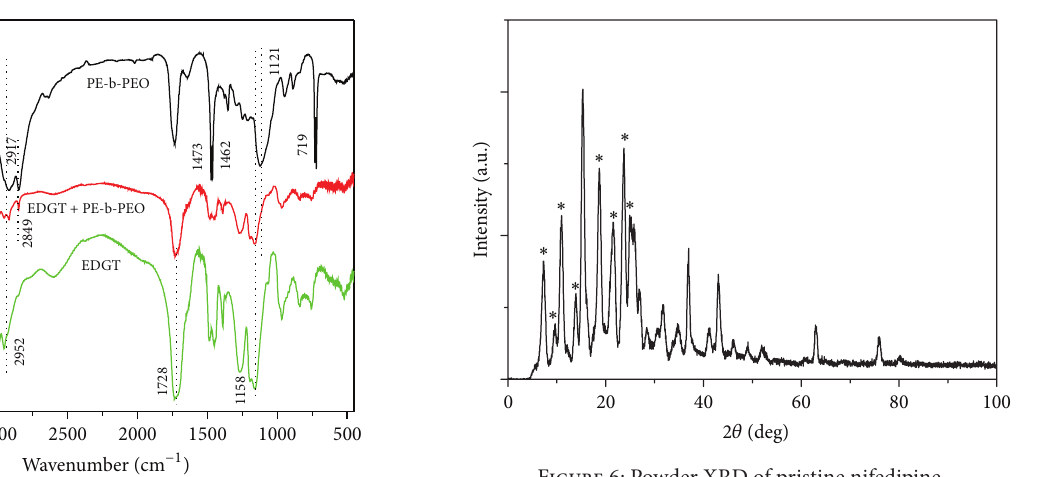
Figure 6: Powder XRD of pristine nifedipine.